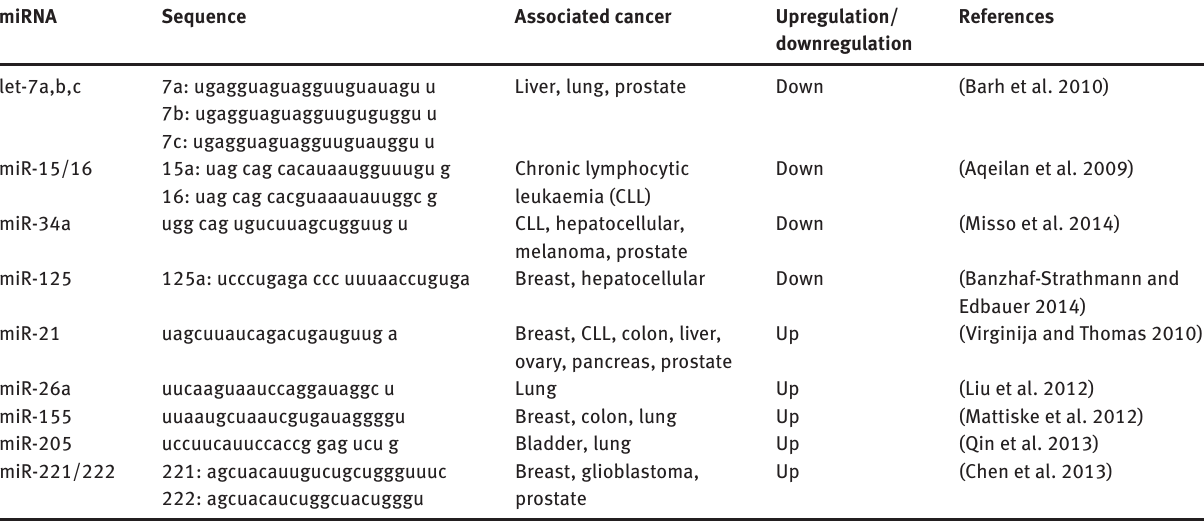
Table 1: Examples of commonly deregulated miRNAs in cancer.